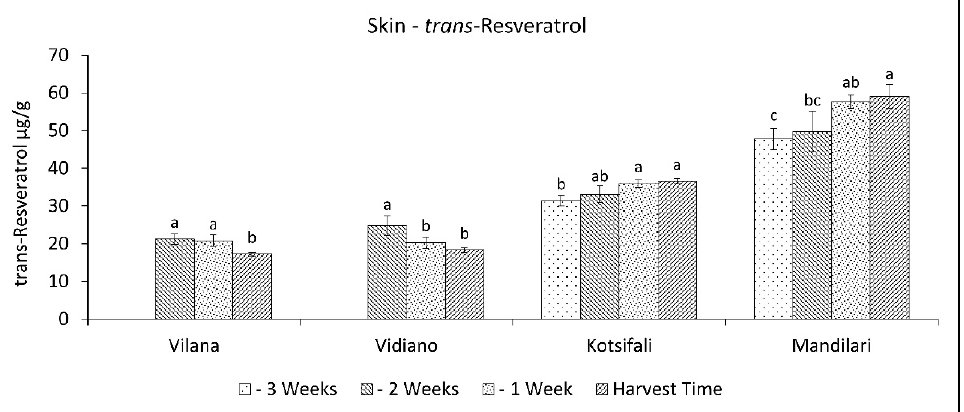
Figure 7. Skin trans-resveratrol content (mg g −1 skin FW) of Vilana, Vidiano, Kotsifali and Mandilari cultivars during ripening. The error bars represent the standard errors of the means. Different letters indicate statistically significant differences among weeks, according to Duncan’s multiple range test ( p ≤ 0.05).